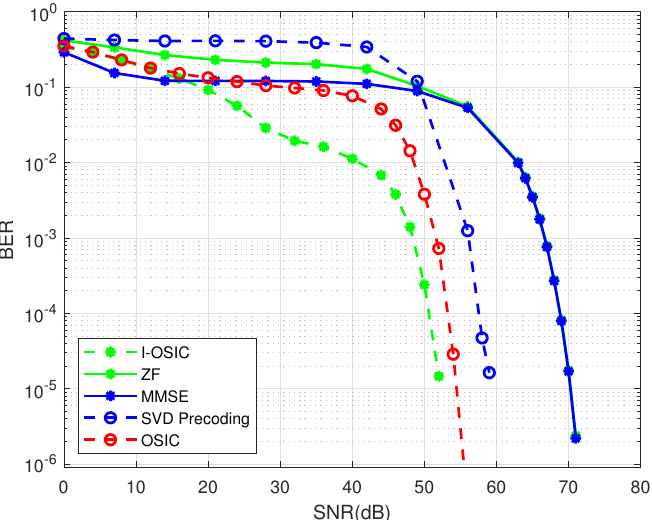
Figure 12. System BER performance when the link misalignment error is 18